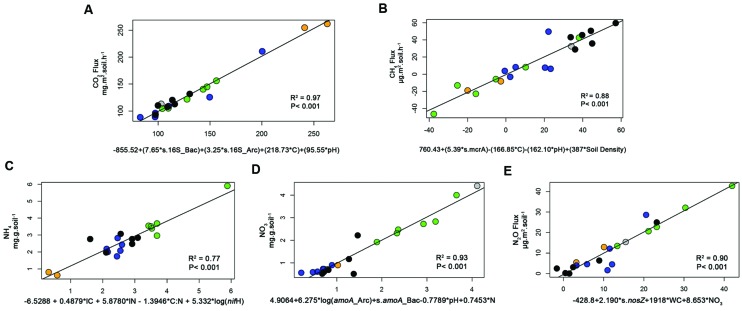
Linear regression analyses (reporting the R2 and P-value) between selected processes, CO2 fluxes (A), CH4 fluxes (B), NH4+ prediction (C), NO3- prediction (D), N2O fluxes (E), and an equation made with the coefficients from the best multiple regression result for each process (for details please see Methods and the Supplementary Information “Regressions”). These graphs demonstrate the fit (R2) of our data in the prediction equations based on the multiple regression analyses. Data are shown for four different land use types, forest (green), pasture (black), soybean 25 years (blue), soybean 2 years (orange squares, and adjacent forest in gray).